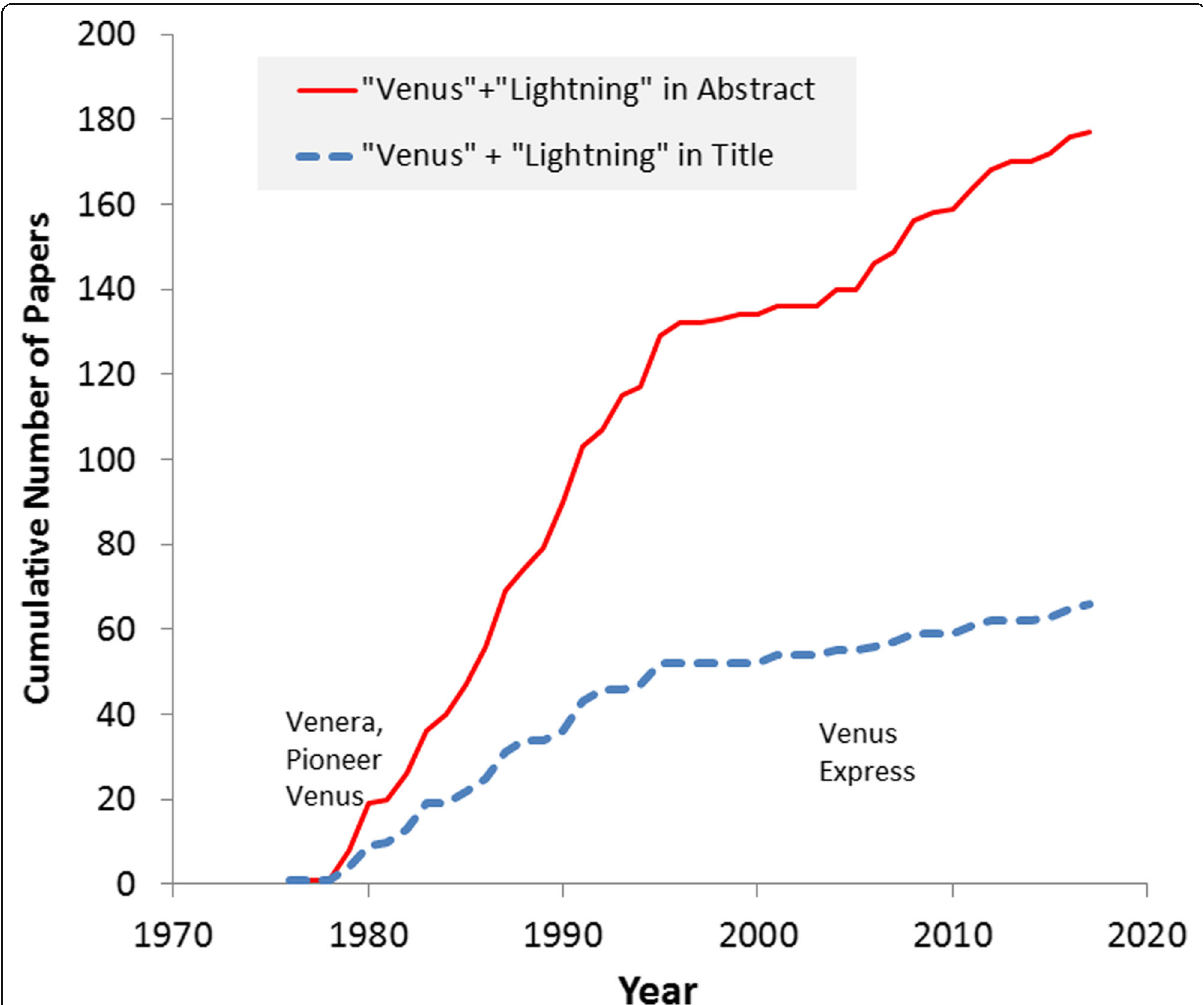
Fig. 1 The growing corpus of scientific literature on the topic (Smithsonian-ADS refereed paper search 9/28/2017). Search keywords “ Venus ” and “ Lightning ” were both required in the title or the abstract; the abstract search turns up more general papers as well as Venus-lightning-specific articles. The curves have a plateau in the 1995 – 2007 period as the Pioneer Venus interpretation debate fizzles out; the pace of papers increases a little after Venus Express data begin to